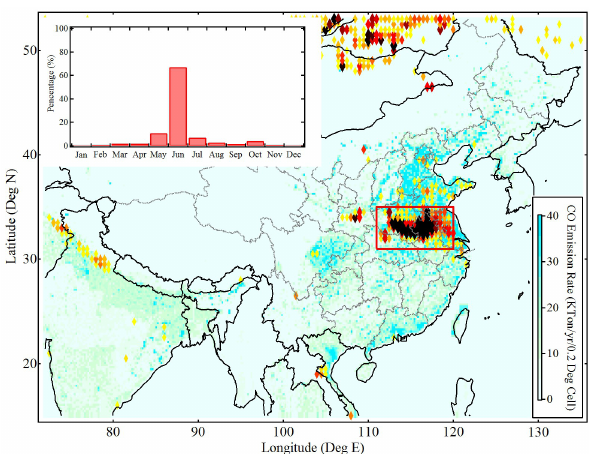
Fig. 10. A map showing anthropogenic emission inventory of CO (Zhang et al., 2009) and averaged active fire data during 2002–2012 over Asia based on MODIS Collection 5 Active Fire Product. The upper left corner shows seasonal variation of month percentage of active fires during the 11yr. Note: the color (from yellow to black) and size of rhombuses represent the intensive of fires per